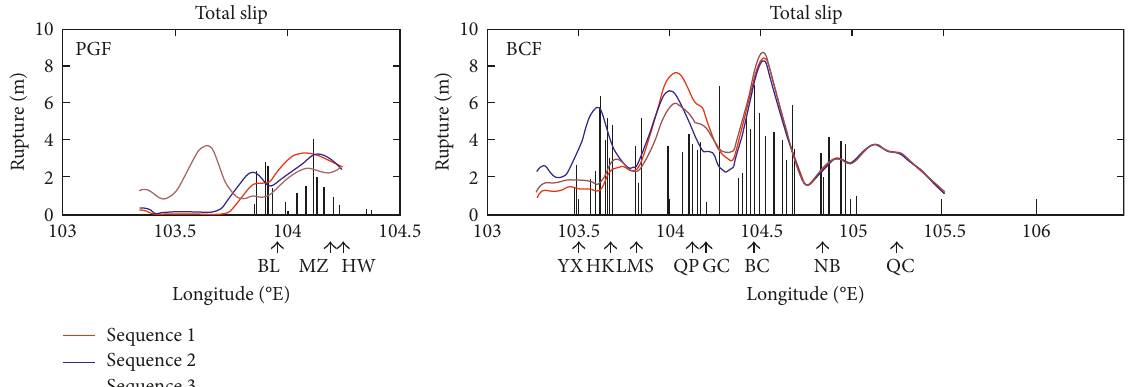
Figure 7: Comparison between inverted slip of the near-surface fault and coseismic displacements from field survey. Bar graph is the surface